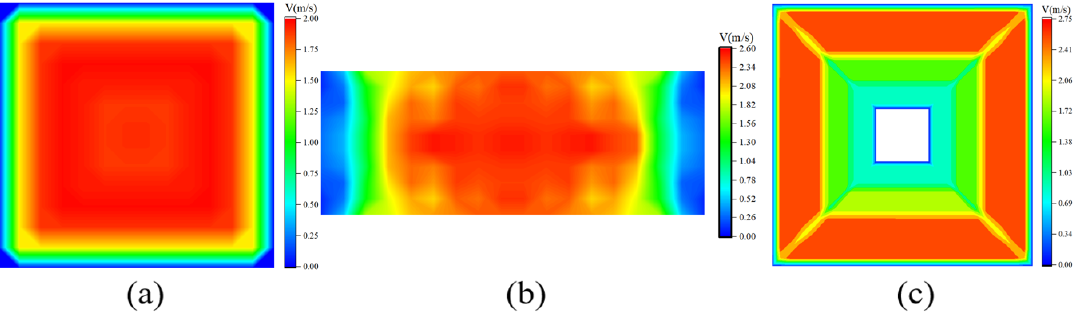
Figure 6. Velocity contours of measured results at 15 Hz. ( a ) SGD; ( b ) RGD; ( c ) SCD.